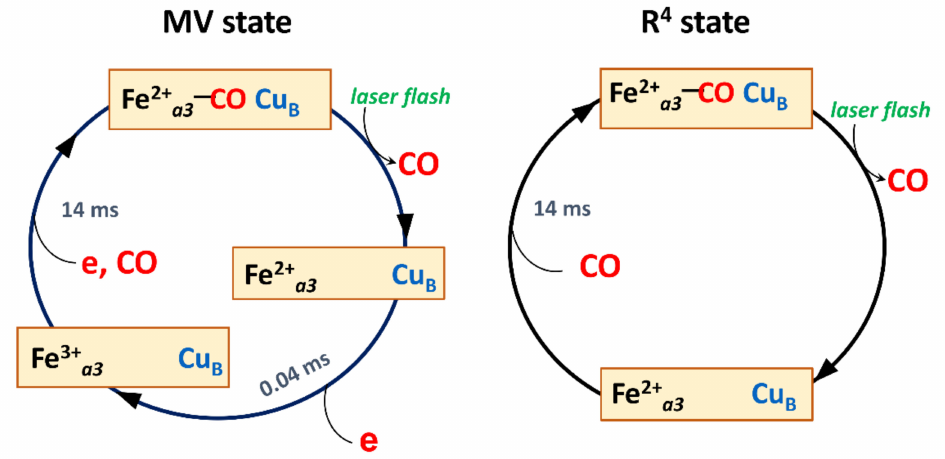
Figure 5. Proposed scheme for a cycle of photolysis and recombination of CO to the heme-copper cytochrome oxidase caa 3 from T. thermophilus (A2 family) in the two-electron-reduced mixed-valence (MV) and fully reduced (R 4 ) states. In the R 4 state, photodissociation of CO from the ferrous heme a 3 iron (Fe 2+ a 3 ) is followed by its rebinding to the heme with τ of 14 ms. In the MV state, in addition to the CO rebinding, there is a transient back-flow of an electron from the binuclear center to the input redox center (heme a , Cu A , and cytochrome c ) with τ of 0.04 ms. Intermediate binding of CO to Cu B is not shown. The scheme is based on time-resolved spectroscopic studies